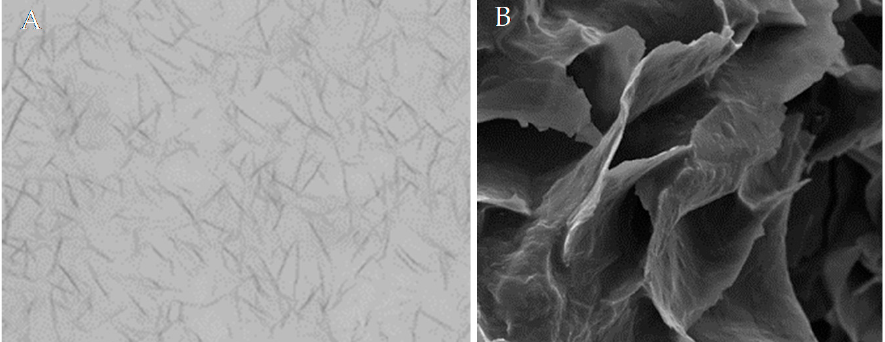
Figure 6. Visualization of the microstructure of 10% sunflower wax in canola oil. ( A ) Polarized light microscopy, image height 500 µm. ( B ) Cryo-SEM image height 125 µm. The agreement of the structural hypothesis derived is not intrinsic. For details of the experimental method, see [66].